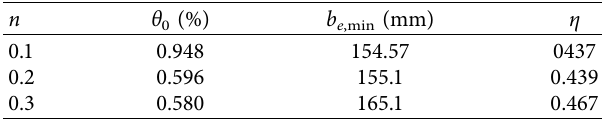
Figure 22: Effective width of core walls with varied axial com- pression ratios. Table 5: Minimum effective width of core walls with axial com- pression